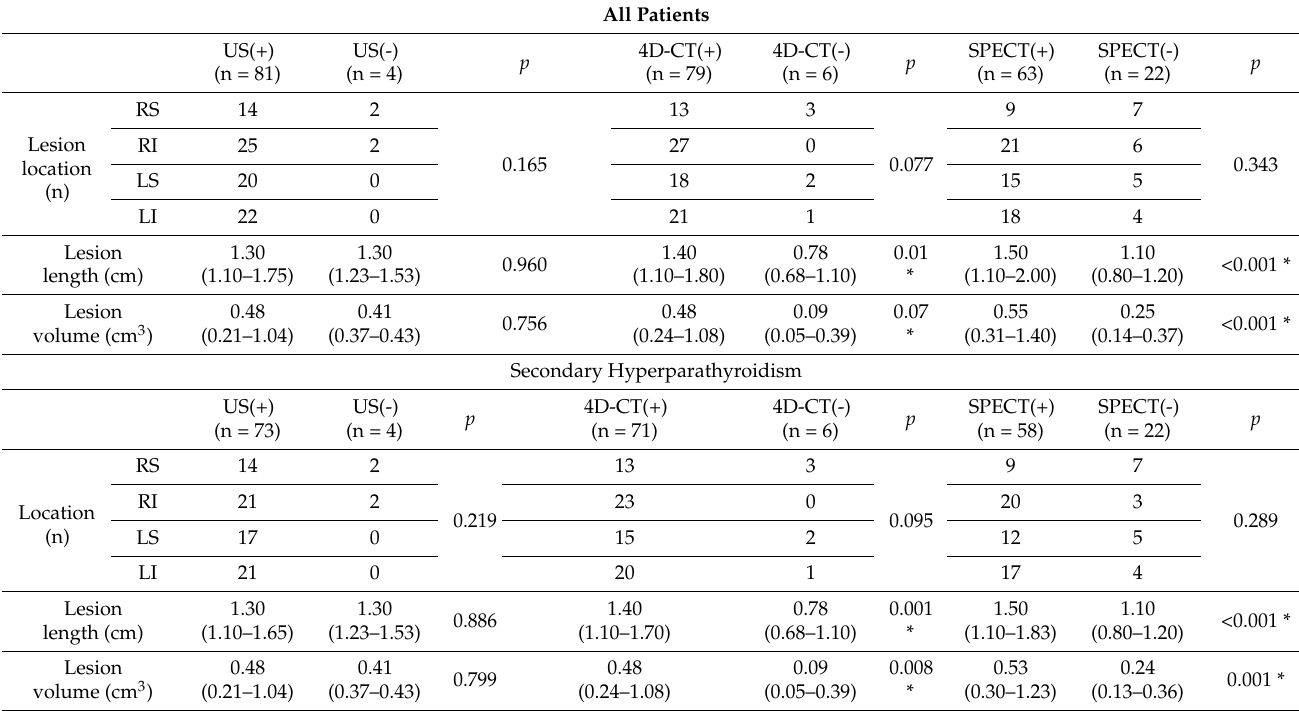
Table 5. The Effect of Image Features on Different Imaging Modalities. All Patients